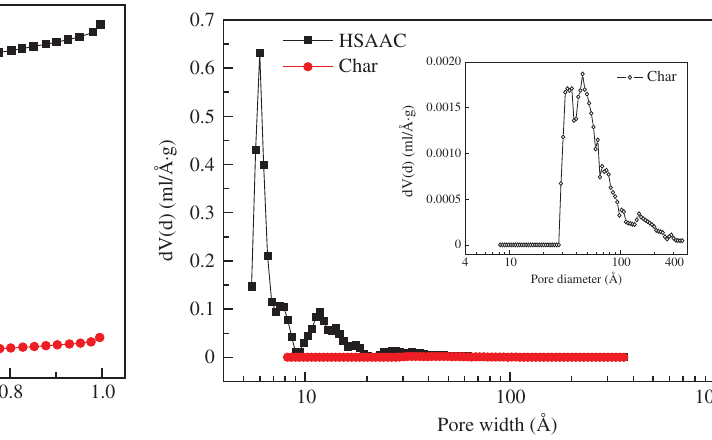
Figure 6: Pore size distribution of char and high surface area activated carbon